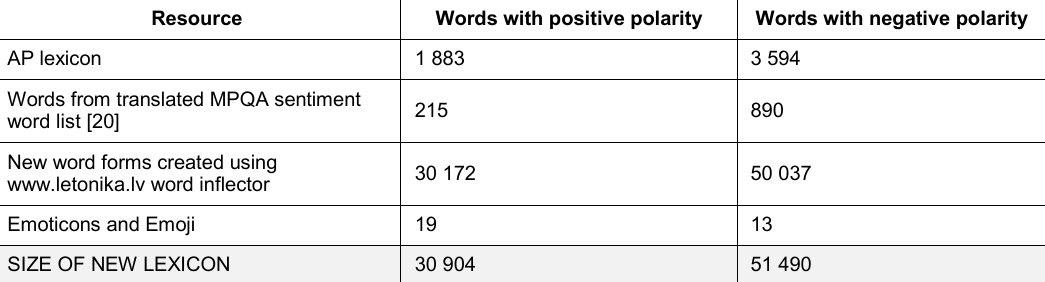
Table 2. Word polarity lexicon sources